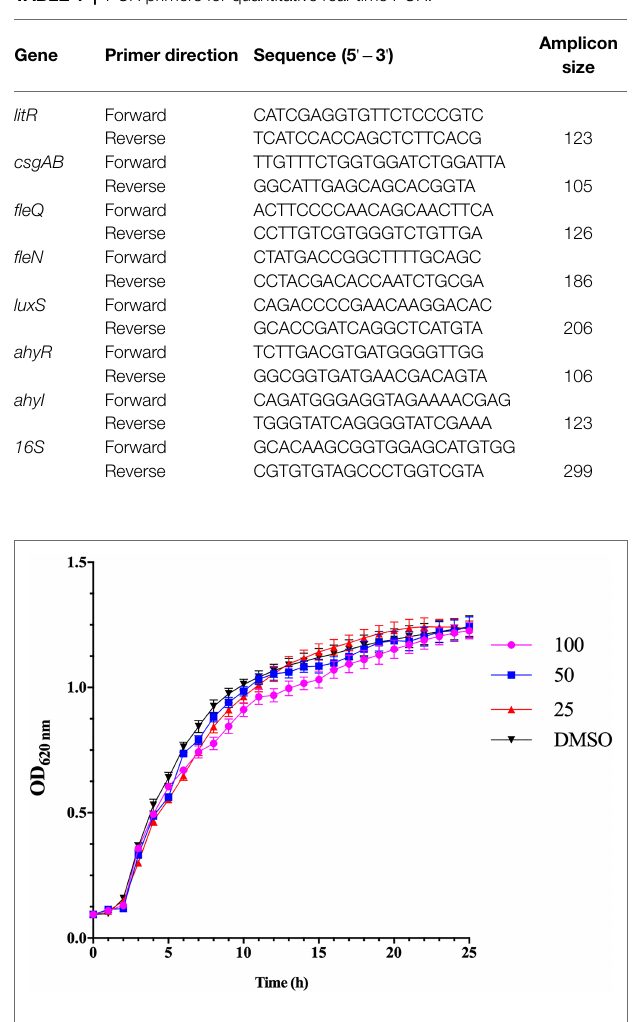
FIGURE 1 | Effect of esculetin at sub-MICs (25, 50, and 100 μ g/ml) on growth of Aeromonas hydrophila SHAe 115. The data represent the mean values of experiments performed in triplicates. Data are presented as the absorbance of mean ± SD